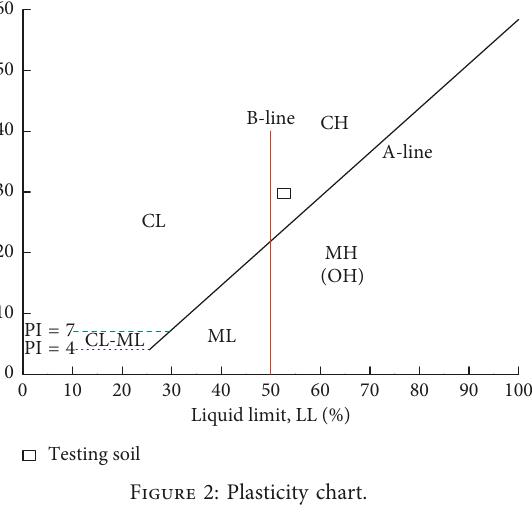
Figure 2: Plasticity chart.